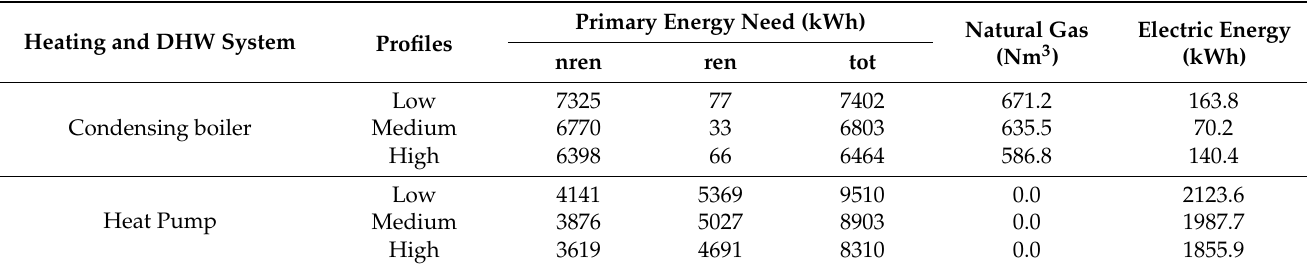
Table 5. Primary energy needs for the three analysed profiles as functions of the heating and domestic hot water (DHW) production